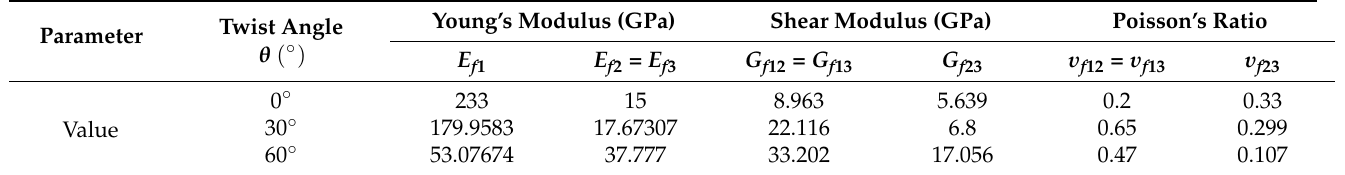
Table 3. Effective elastic properties of fiber calculated from Equation